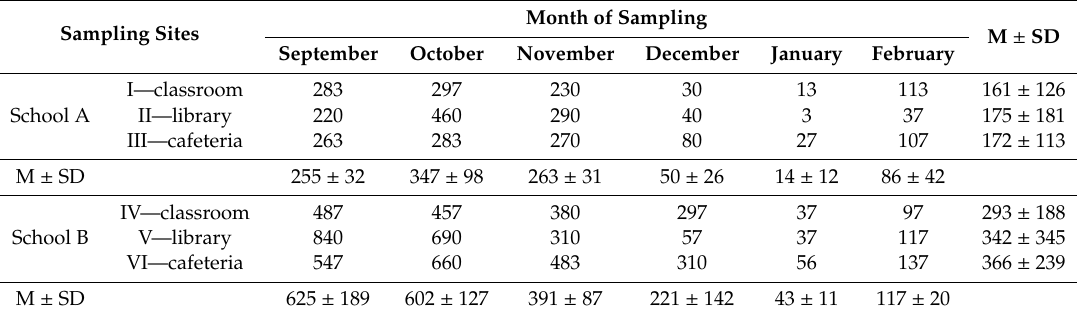
Table 4. Number of fungi in air (CFU m − 3